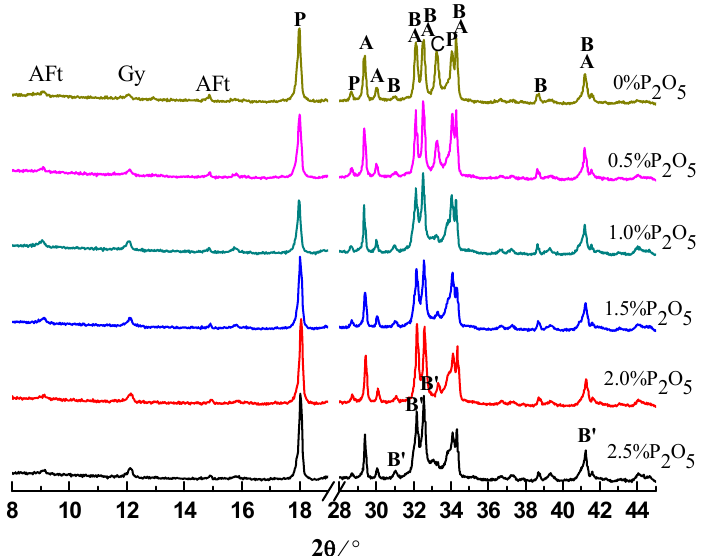
Figure 4. XRD patterns of cement pastes hydrated for 1 day. A: C 3 S; B: β -C 2 S; F: C 4 AF; C: C 3 A; P: CH; B ′ : α′ -C 2 S-xC 3 P.